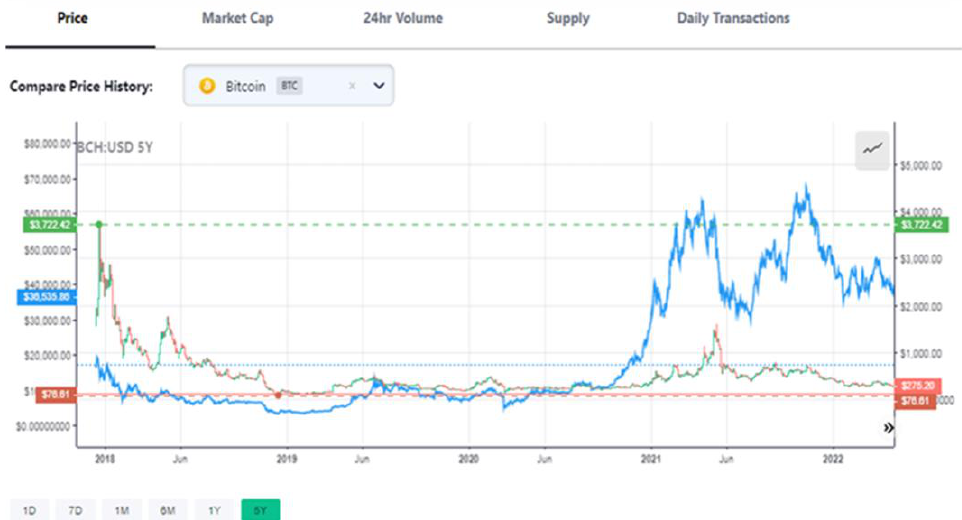
Figure 4. Bitcoin cash price (BCH) in June 2021 was USD 698.3, and in December 2022, the value was USD 17,150.91 [10].